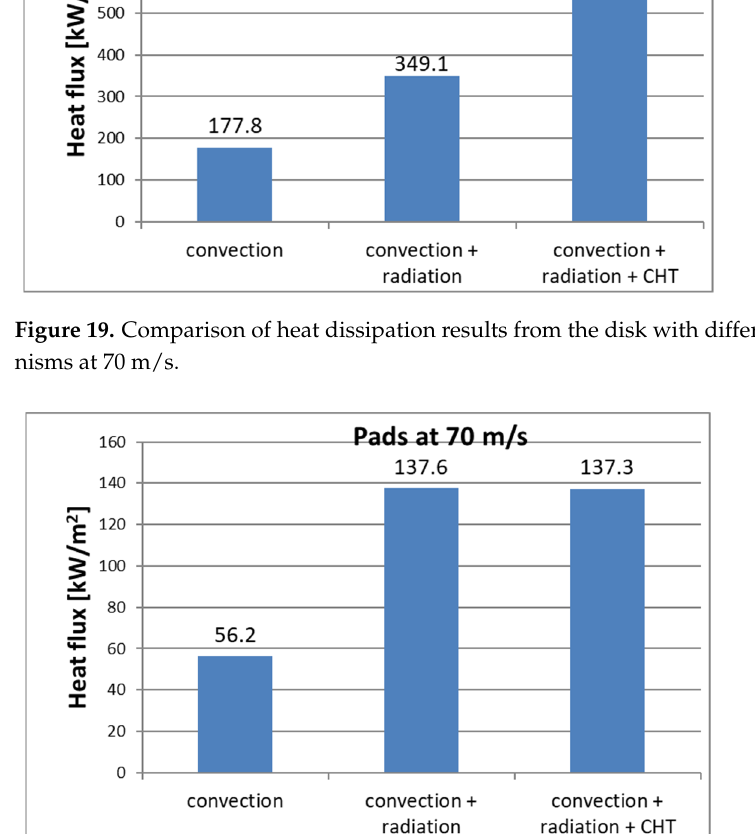
Figure 20. Comparison of heat dissipation results from the pads with different heat transfer mechanisms at 70 m/s.